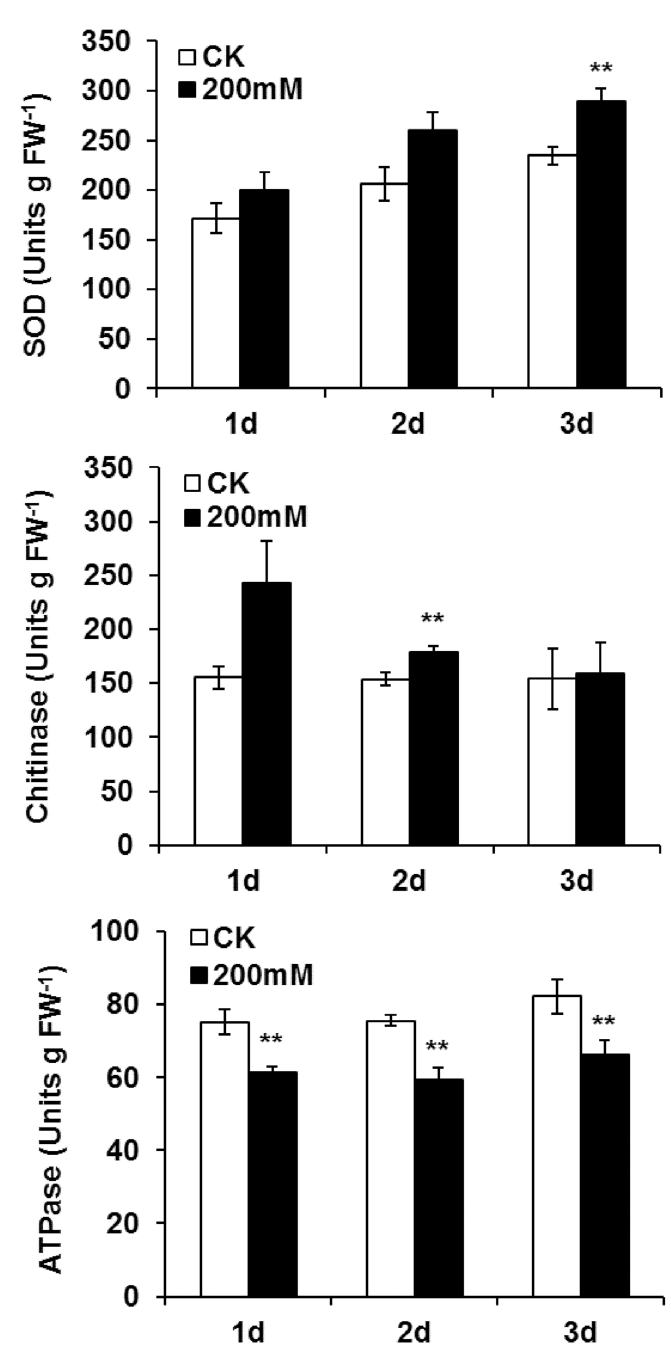
Fig 7. Effects of salt-stress treatments on enzyme activities in leaves of B . napus ‘ Nannongyou No. 3 ’ seedlings. Values shown are means ± SD from three biological replicates. ** indicates a significant difference (compared with the control) at p <